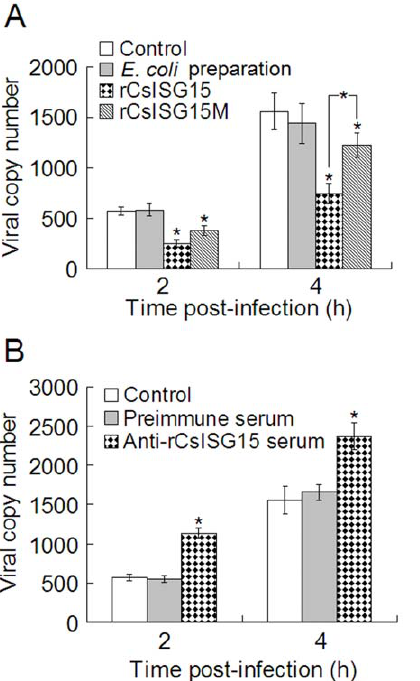
Figure 8. Effect of rCsISG15 and anti-rCsISG15 serum on viral infection. (A) Tongue sole head kidney (HK) lymphocytes were treated with or without (control) rCsISG15, rCsISG15M, or Escherichia coli preparation, and then infected with megalocytivirus. (B) Tongue sole HK lymphocytes were pre-treated with or without (control) anti-rCsISG15 serum or preimmune serum and then infected with megalocytivirus. In both panels, viral numbers in the cells were determined at 2 h and 4 h post-infection. Values are shown as means 6 SE (N=5). N, the number of repeated experiments. * P , 0.05; ** P , 0.01.